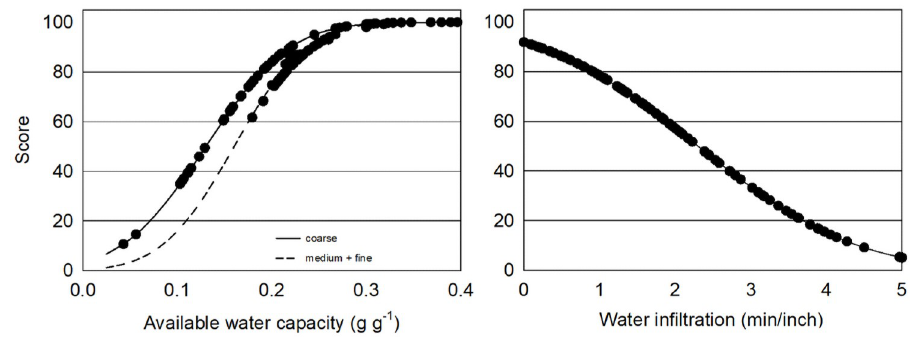
Fig 1. Soil water relations function indicators: Available water capacity (g g -1 ) and water infiltration (min/inch).